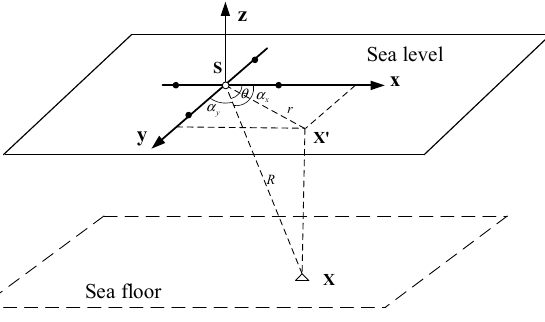
Figure 1. The positioning geometry principle with ultra-short baseline.